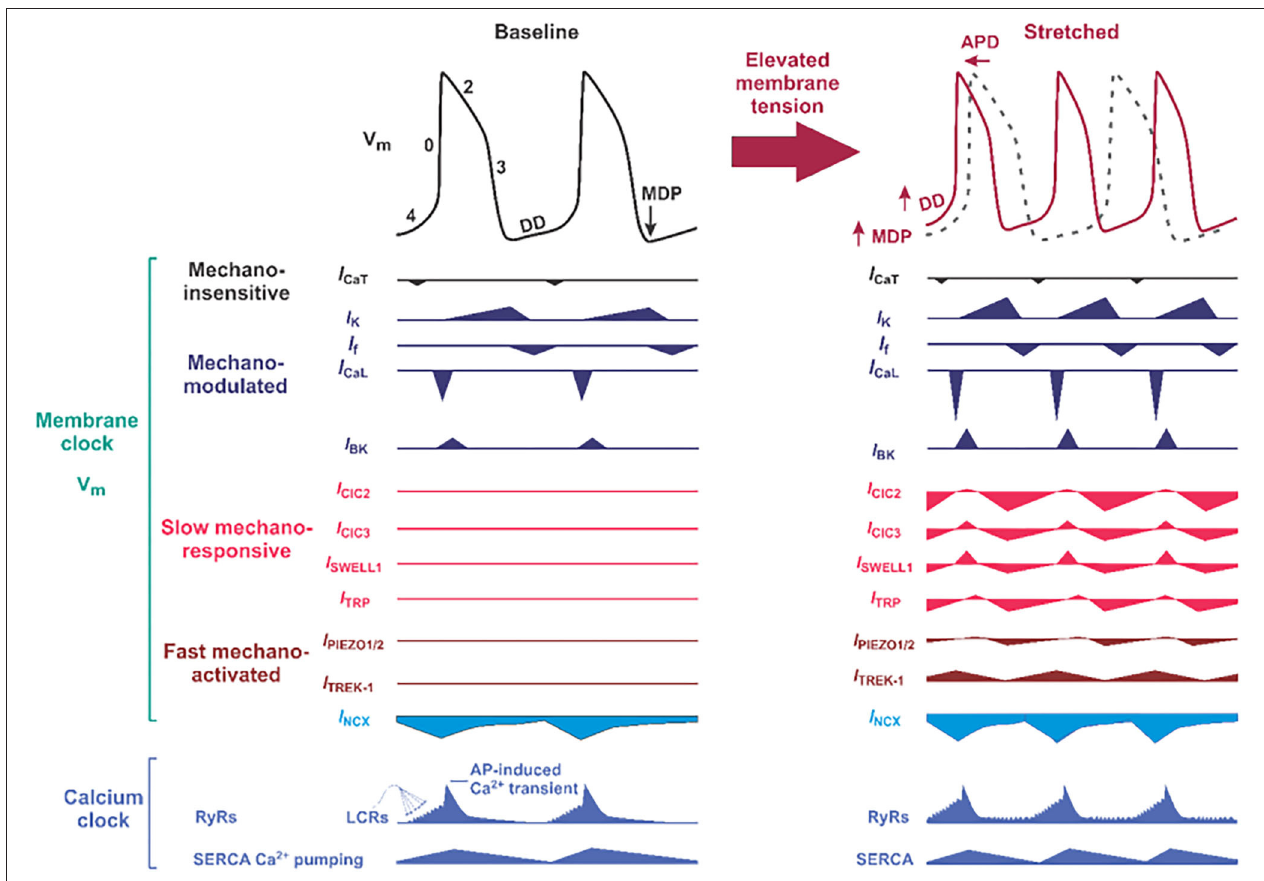
FIGURE 3 | Proposed molecular composition of the mechano-electrical signal transduction in the sinoatrial node (SAN) cell. ( Left ) Typical SAN membrane action potential (black trace) and the timing of membrane (V m ) clock and calcium (Ca 2 + ) clock components of the coupled-clock pacemaker system are shown. The phases of the action potentials are labeled including phase 4, in which diastolic depolarization (DD) that is key to automatic pacemaker activity takes place. APD, action potential duration; MDP, maximum diastolic potential; DD, diastolic depolarization; I Ca,T and I Ca,L , T- and L-type voltage-dependent Ca 2 + currents; I NCX , sodium-calcium exchange current; I K , rapid ( I Kr ) and slow ( I Ks ) delayed rectifier potassium currents; I f , HCN4 “funny” current; SERCA, sarco-endoplasmic reticulum ATPase; LCRs, local Ca 2 + releases. Below “classical” ion channels defined as mechano-modulated as indicated by various authors ( 38–40) which can have their normal activity altered by mechanical stress, proposed slow mechano-responsive, and fast mechano-activated ion channels are shown. ClC, chloride channels; SWELL1, swelling-activated leucine-rich repeat containing 8 (LRRC8) family chloride channels; TRP, transient receptor potential ion channels. ( Right ) Proposed changes in SAN action potential morphology (solod red trace on top of the black dotted trace for baseline condition) under mechanical stress. Below, proposed contribution of slow mechano-responsive and fast mechano-activated ion channels is shown for each ion